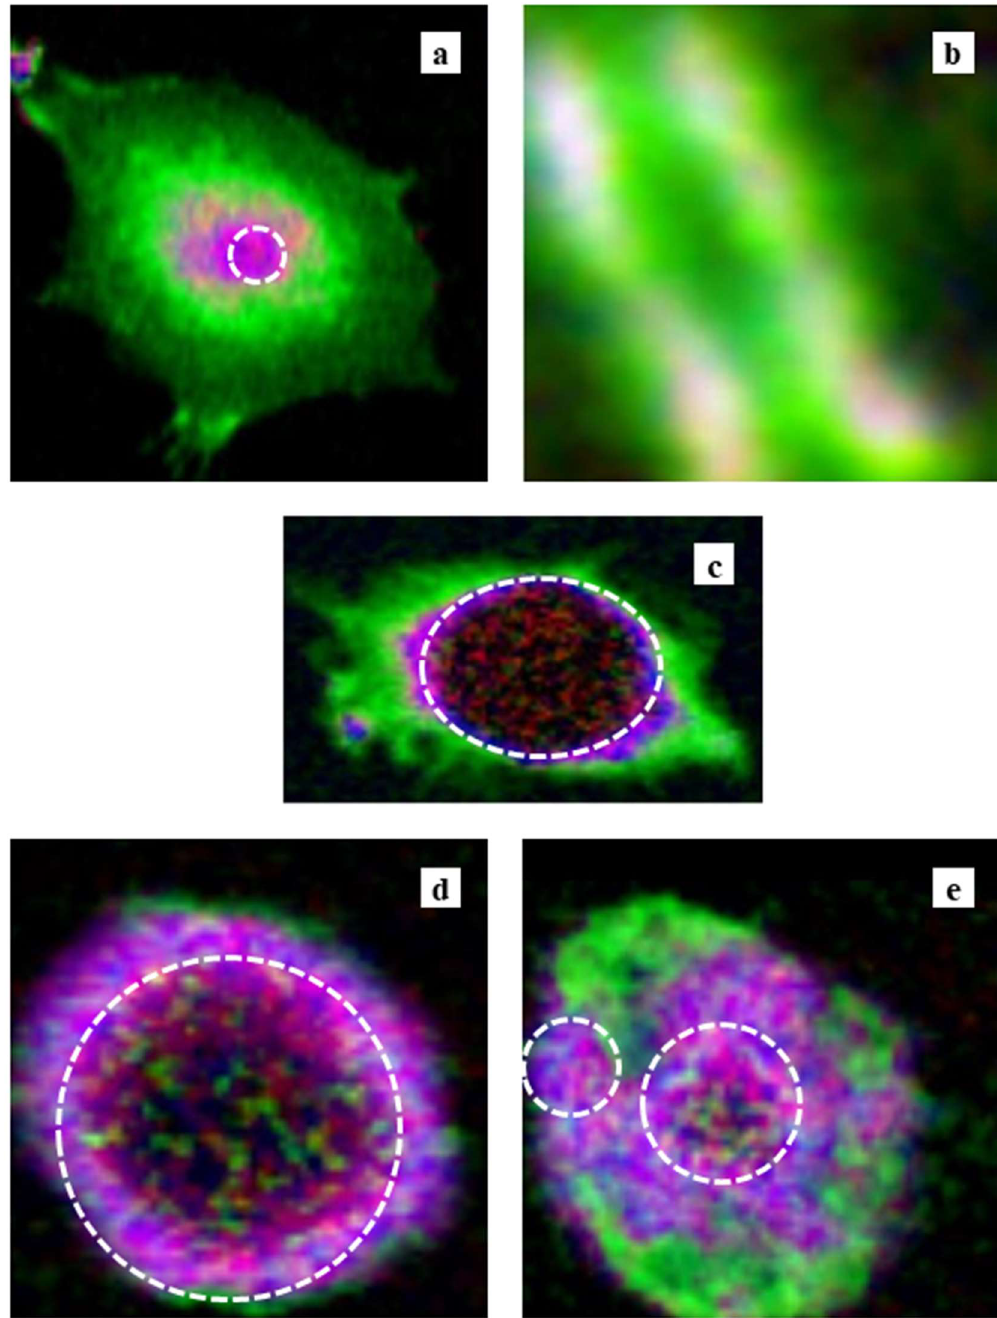
Figure 9. RGB expression of the images of the ( a ) CHO cell, ( b ) chromosome, ( c ) HeLa S3 cell, ( d ) isolated nucleus, and ( e ) apoptotic nucleus. DNA, proteins other than histone, and histone are displayed as red, green, and blue, respectively. Areas possibly unreliable for the analysis are encircled by dashed lines.